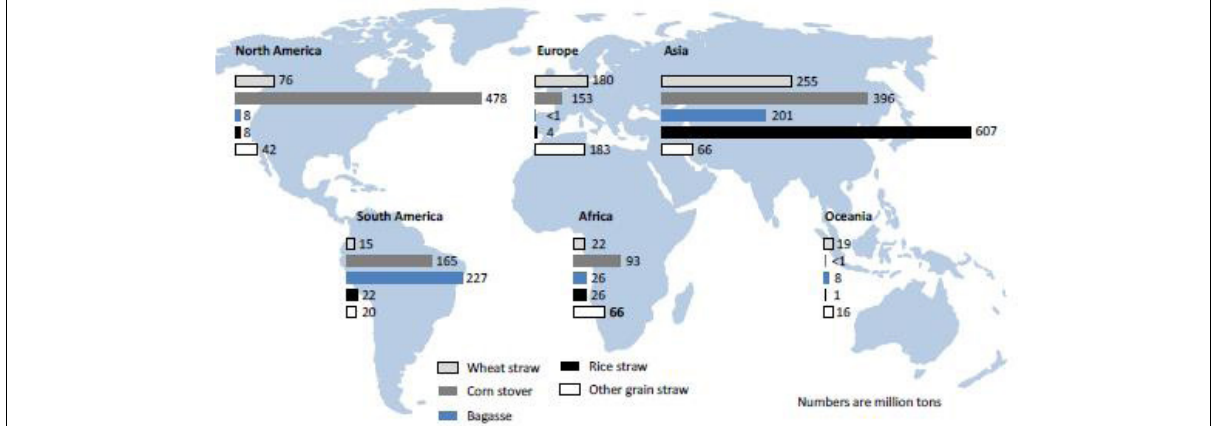
Figure 2: The circular bioeconomy and its elements.